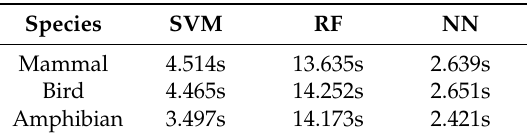
Table 2. The time statistics of the three machine learning models with 5000 training samples and 5000 prediction